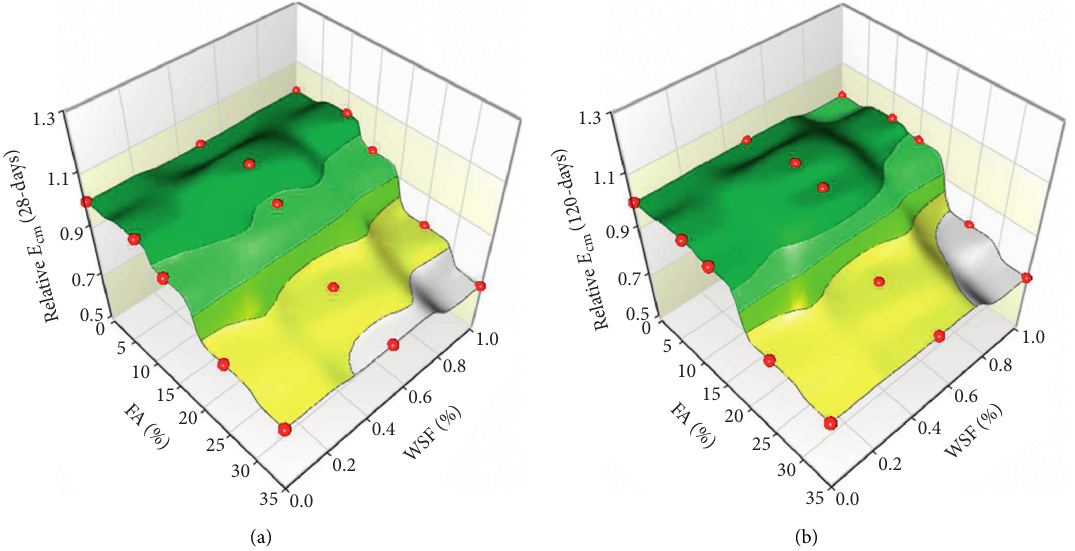
Figure 9: Relationship between FA, WSF, and relative (E)